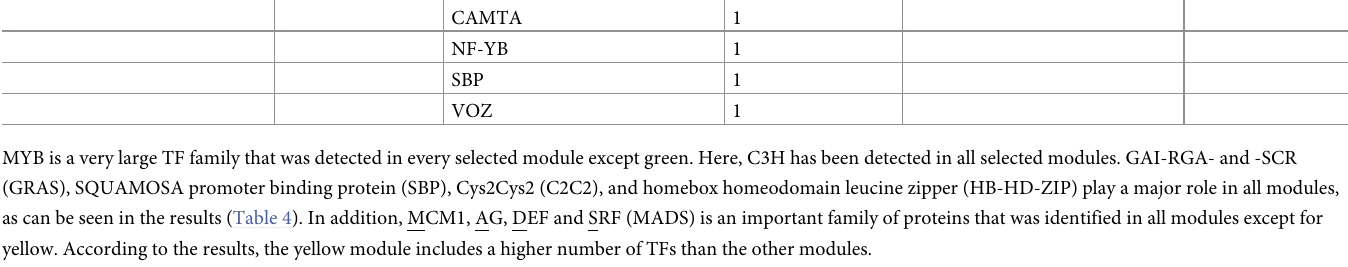
in secondary metabolites transformation, as it provides a higher expression level of major transporters.